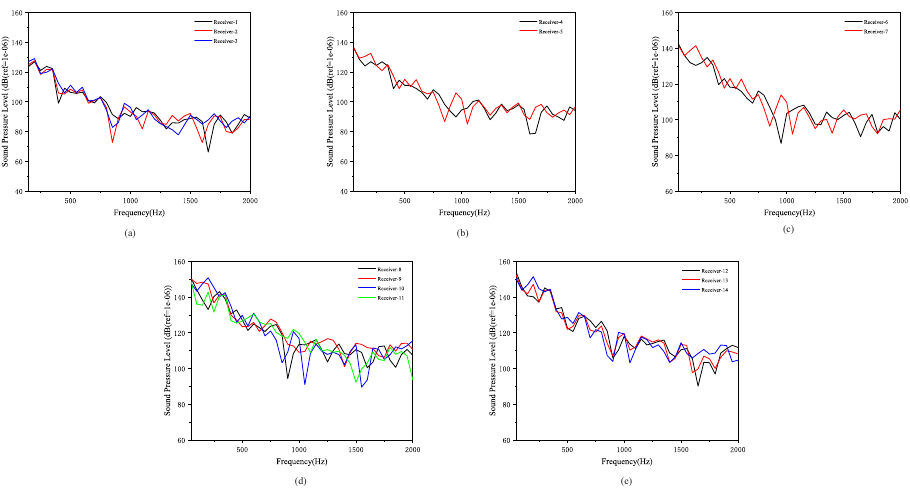
Figure 6. Spectral characteristics of sound pressure at different monitoring points along the flow direction considering pressure pulsation excitation. ( a ) Receiver 1–3 ( b ) Receiver 4–6 ( c ) Receiver 6–7 ( d ) Receiver 8–11 ( e ) Receiver